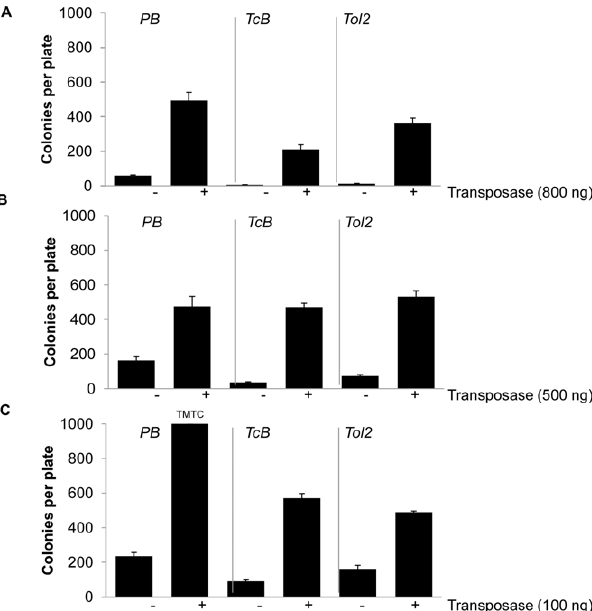
Figure 6. Comparison of piggyBac , TcBuster , and Tol2 at varying transposase: transposon ratios. HEK-293 cells in 6-well plates were transfected in triplicate with the indicated amount of transposase helper plasmid ( + ) or pUC19 ( 2 ) and plasmids carrying the neomycin- resistance transposon for each system. The amount of transposon plasmid transfected was 200 ng ( a ), 500 ng ( b ), or 900 ng ( c ). In c , the piggyBac ( + ) transposase plates had approximately 1000 colonies, too many to count (TMTC). Cells were diluted 1:750 onto 10 cm plates in media containing geneticin for selection and incubated for two weeks to allow drug-resistant cells to form colonies that were fixed, stained and counted. Error bars represent the SEM (n=3).